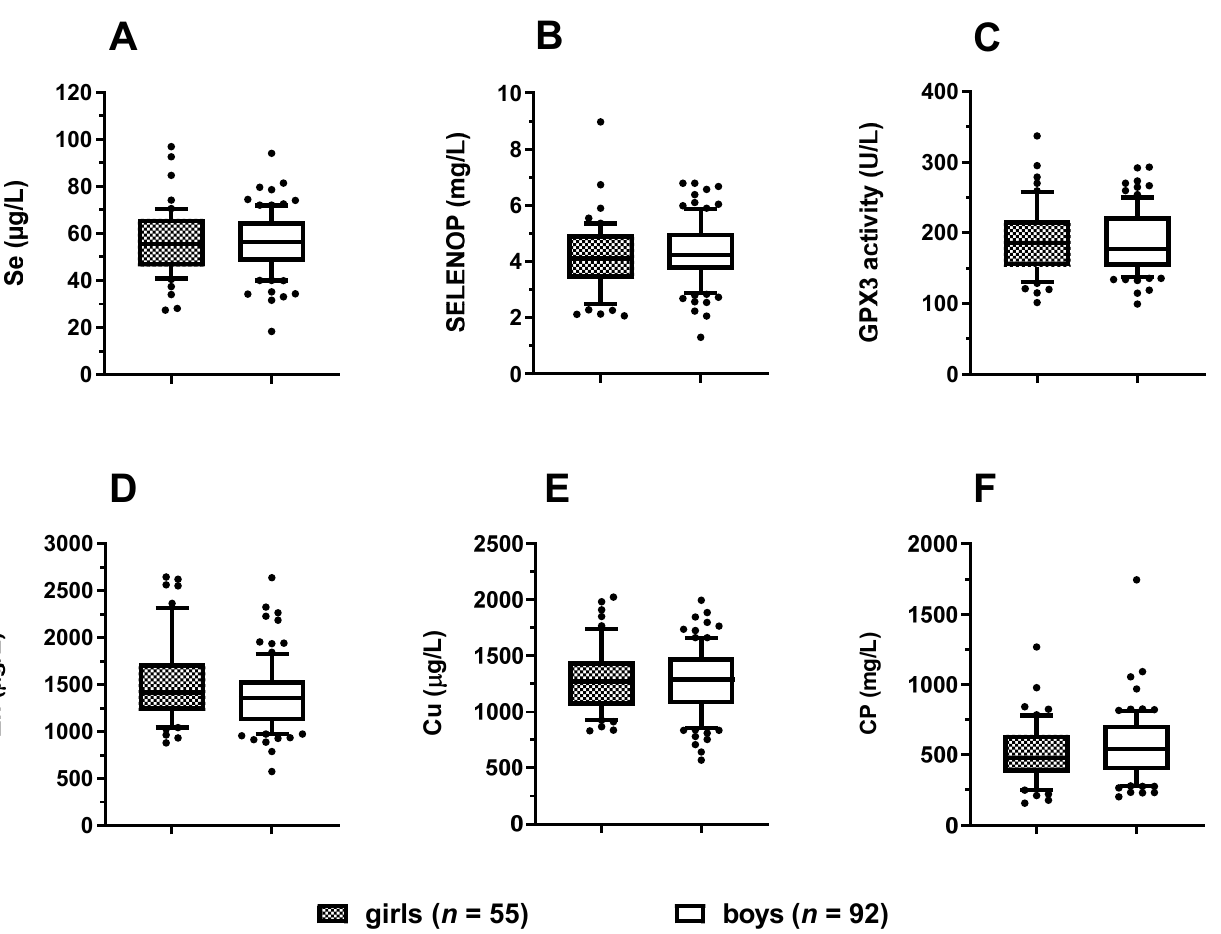
Figure 2. Comparison of serum TE (trace element) concentrations between female and male paediatric patients. All six TE biomarkers were compared between the groups of diseased girls ( n = 55) and boys ( n = 92). There were no significant sex-specific differences in ( A ) serum Se, ( B ) SELENOP concentrations, or ( C ) GPX3 activity. Similarly, ( D ) serum Zn, ( E ) Cu, or ( F ) CP concentrations did not differ between the sexes. Data are presented as box plots (10th–90th centiles); Student’s t-test or Mann–Whitney U test was used. All tests were two-sided and p -values < 0.05 were considered statistically significant.